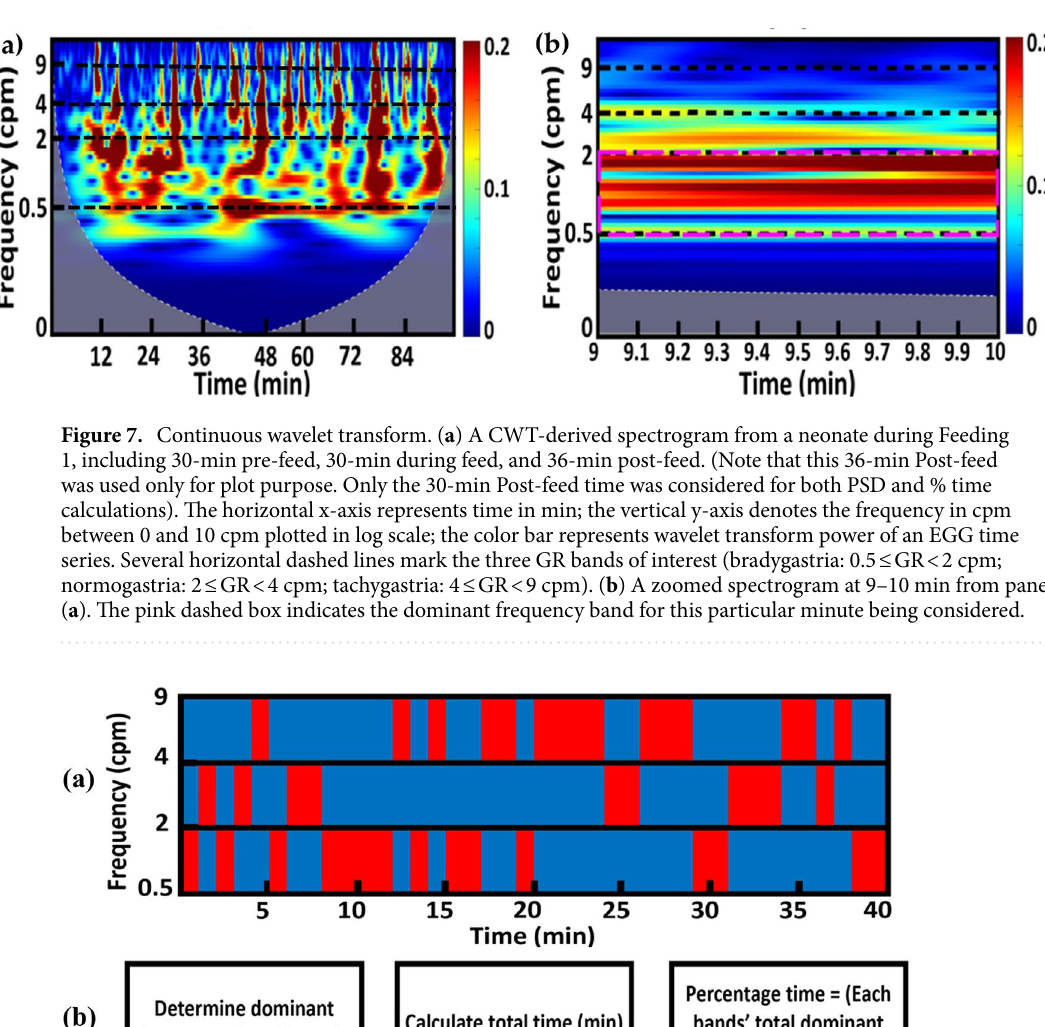
for each sub-feeding period, as demonstrated in Fig. 8a. Each red box represents the dominant frequency band during each minute, and only one box appears per minute. Step 4 The total number of red boxes in each GR band shown in Fig. 8a represents the total time, T GR , during which the corresponding GR was dominant for the selected time period, such as pre-, during, or post-feed (within Feeding 1 or Feeding 2). Only one T GR was chosen per minute among bradygastria, normogastria, and tachygastria. Step 5 The percentage of time spent in each GR band during a selected time period (such as Pre-feed 1, During- feed 1, Post-feed 1, Pre-feed 2, During-feed 2, and Post-feed 2) was quantified by dividing T GR ( = number of red boxes in the respective frequency band) by the total minutes during the chosen feeding period, as outlined in Fig. 8b. Using this method, we obtained respective % bradygastria, % normogastria, and % tachygastria for each neonate in all sub-feeding periods.